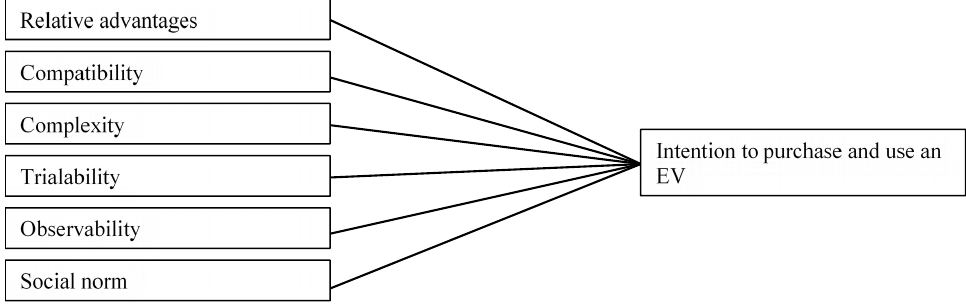
Figure 1. Intention to purchase and use an electric vehicle model (Peters and Dütschke, 2014)